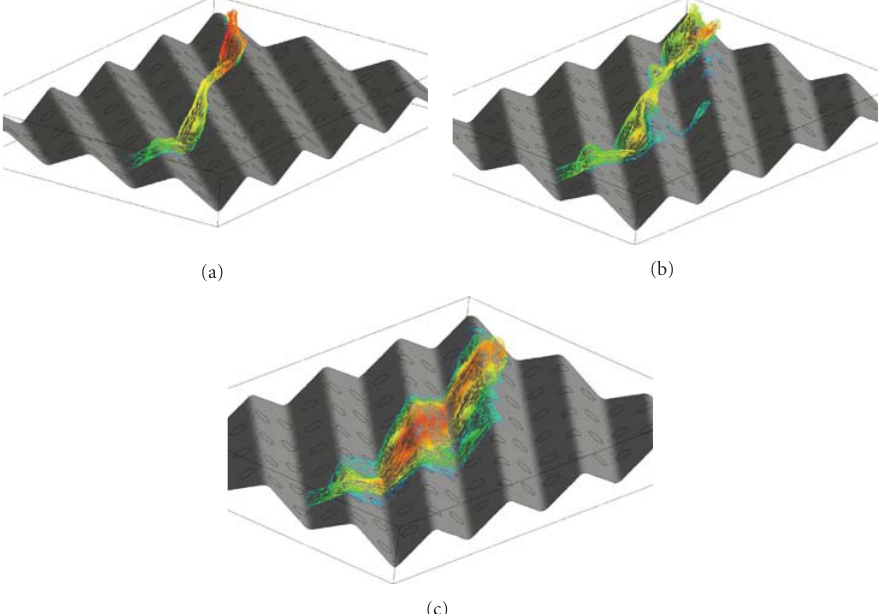
Figure 11: Velocity vectors for three liquids flowing through corrugated sheet of packing smooth crimp apex. (a) Water. (b) Water-glycerol. (c) Silicon-oil.